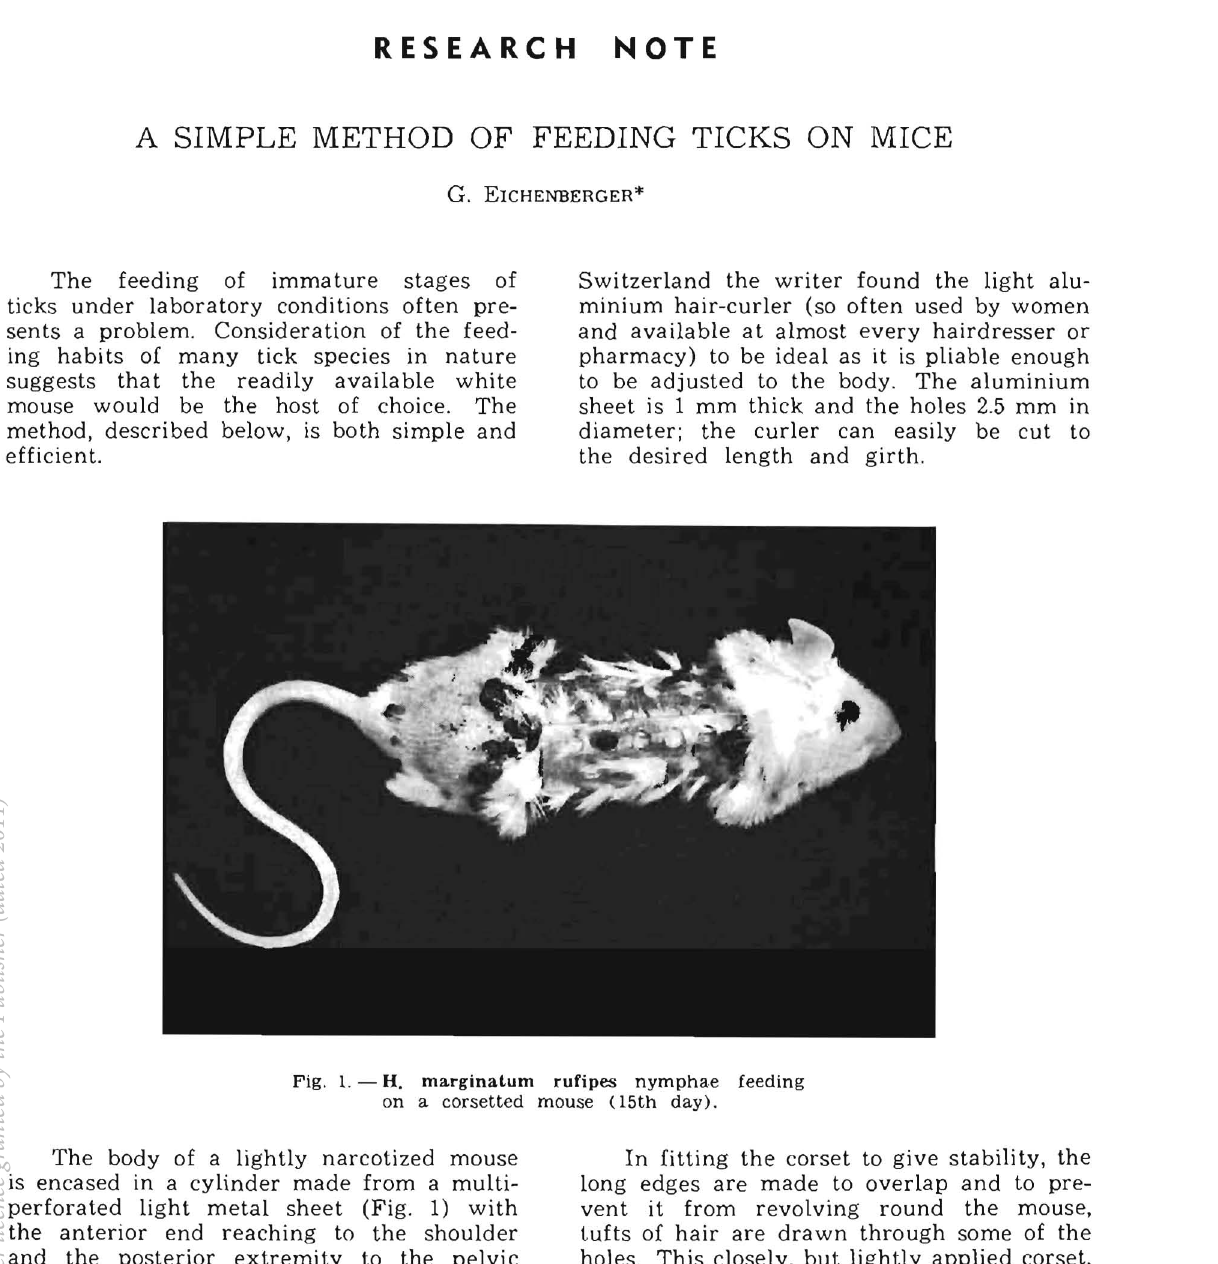
Fig. 1. - H. marginalum rufipes nymphae feeding on a corsetted mouse (l5th